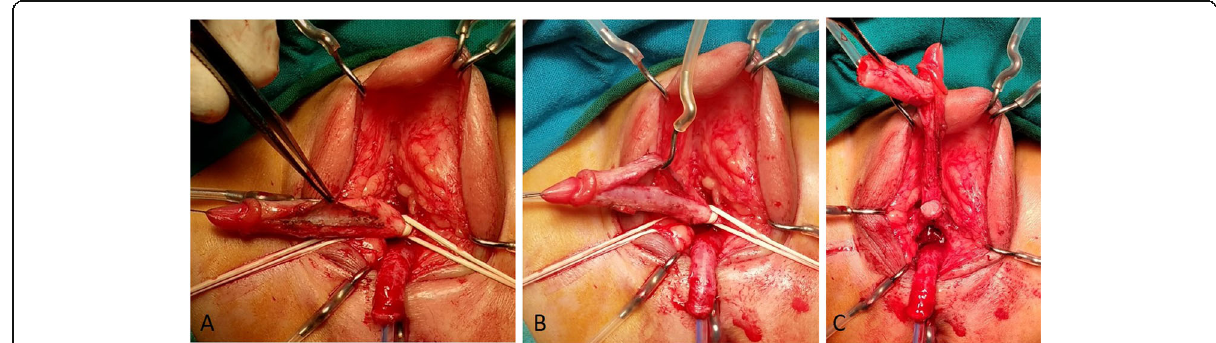
Fig. 4 Feminizing genitoplasty (cont.). An 8-month-old girl with CAH. a , b Dissection of the dorsal neurovascular bundle. c The hypertrophied dorsal corporeal bodies are excised starting distal to the ligature up to the glans